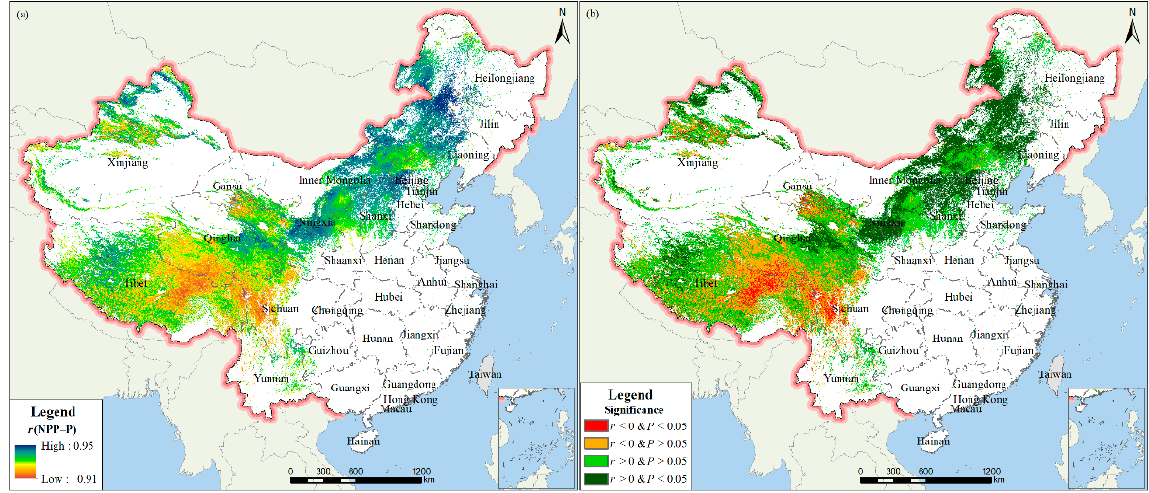
Figure 14. Spatial patterns of ( a ) partial correlation coefficients between ANPP and annual average temperature and ( b ) the corresponding significance levels.